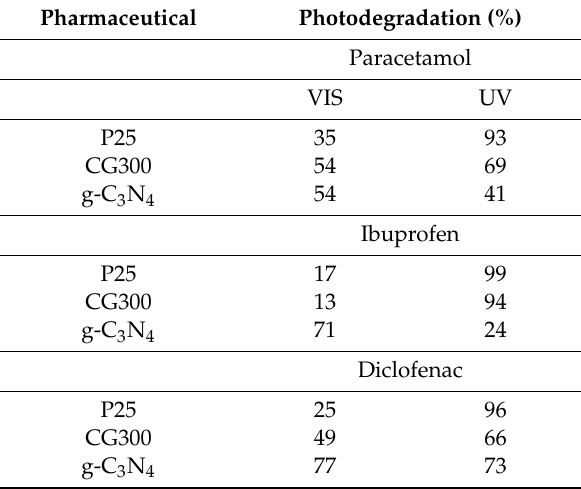
Table 2. Photodegradation e ffi ciency of pharmaceuticals after 2 h of irradiation.